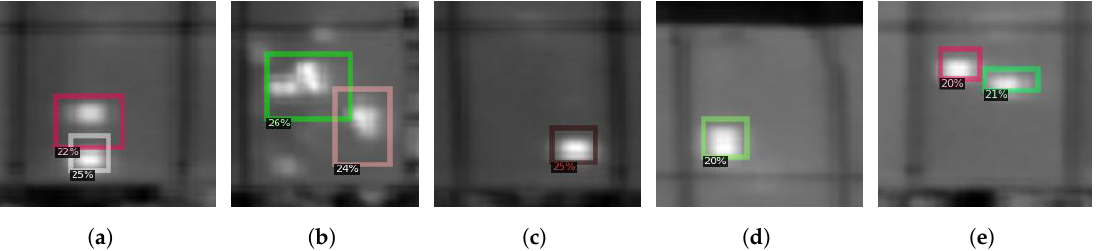
Figure 12. Five different hotspots ( a – e ) detected using our region-based CNN algorithm on the dataset acquired at Montalto Di Castro, Italy.